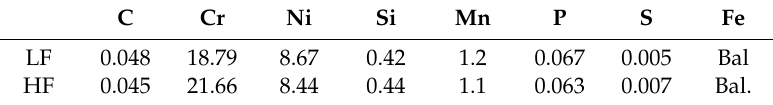
Table 1. Chemical composition of cast stainless steels (wt%).